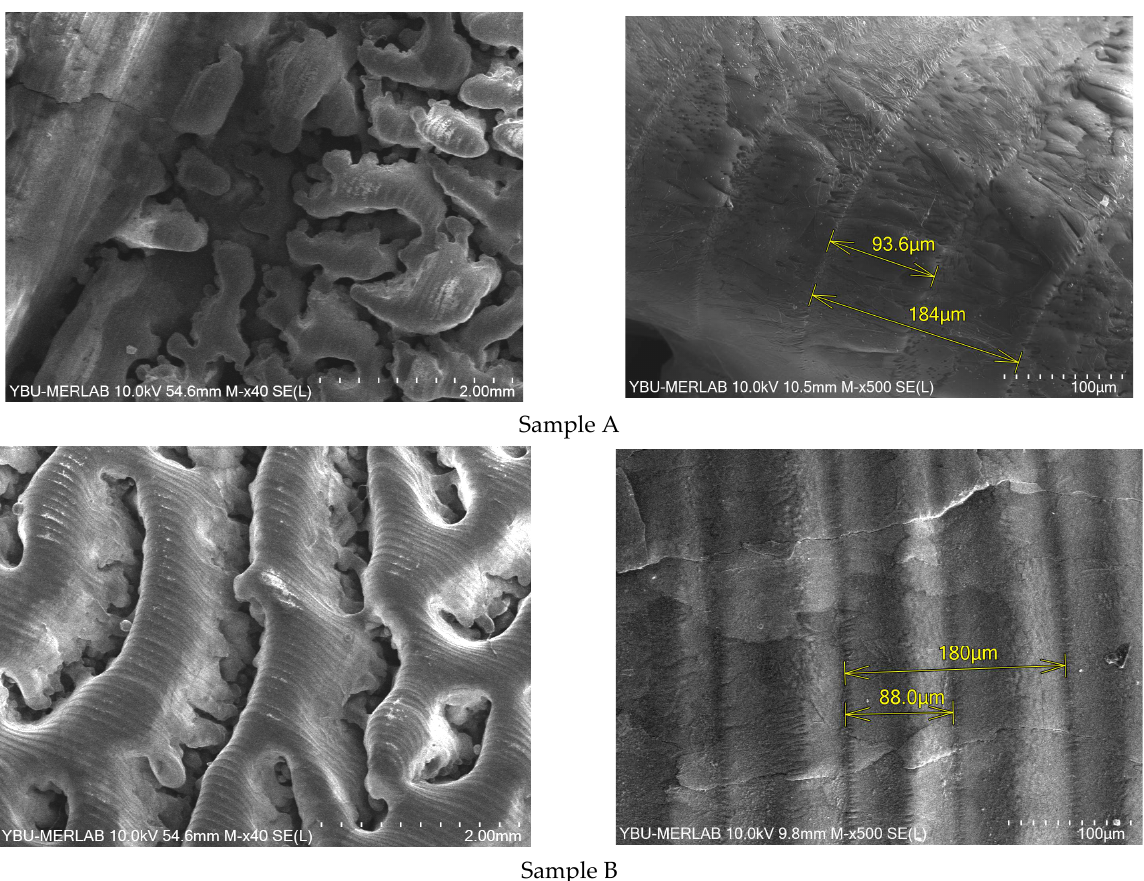
Figure 14. SEM images of alumina samples printed using the developed preheating system: with 20 W preheating laser power (Sample A) and 30 W (Sample B)